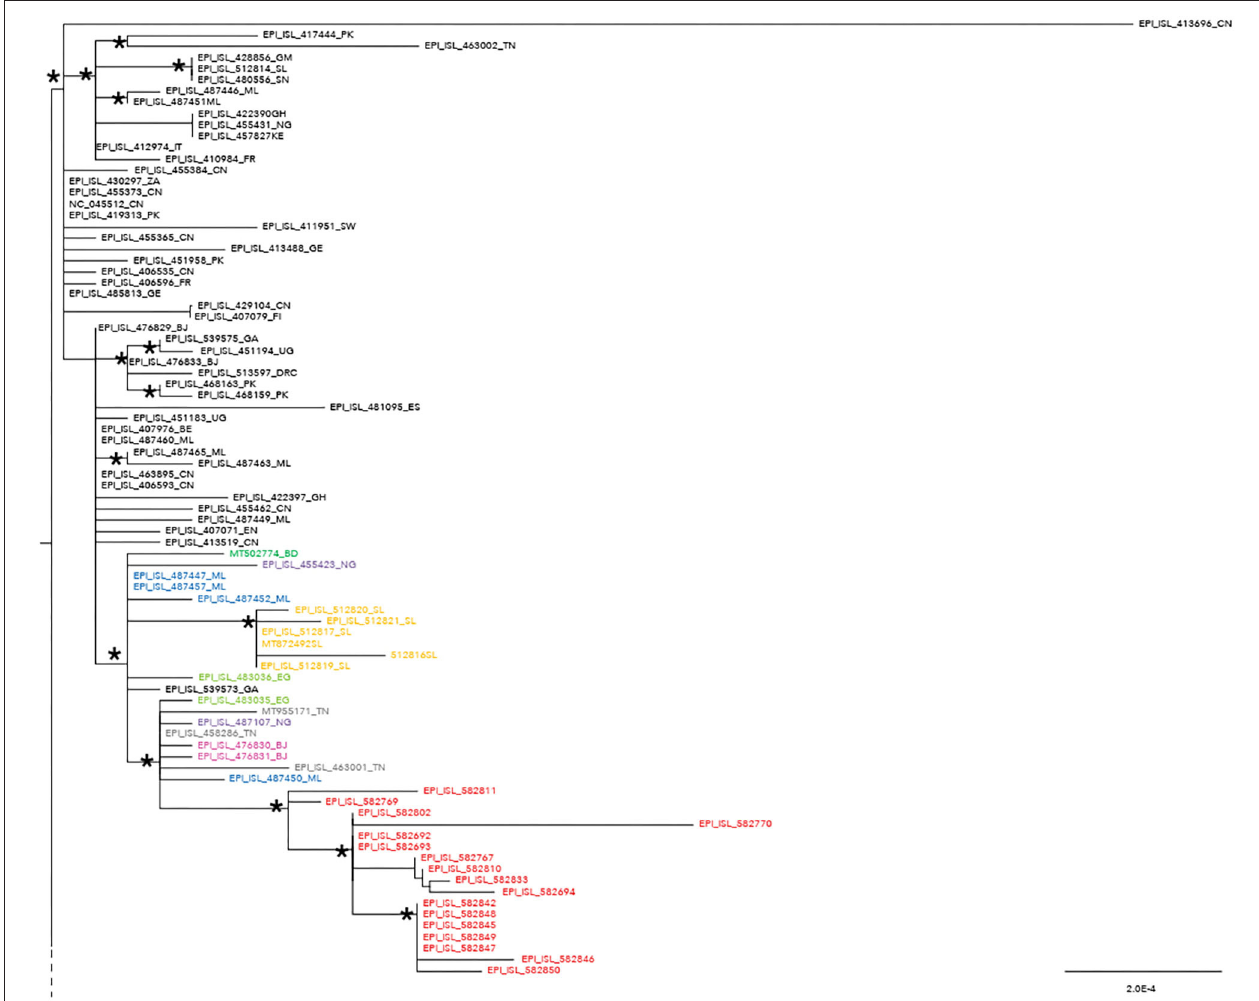
FIGURE 1 | Phylogenetic analysis highlighting the selected clade extrapolated from the whole tree and focusing on the 17 severe acute respiratory syndrome coronavirus 2 (SARS-CoV-2) genomes from migrants (reported in red) belonging to lineage A. These genomes appeared related in a subclade with four genomes from Mali (ML, Mali highlighted in blue: EPI_ISl_487450; EPI_ISL_487447; EPI_ISL_487452; EPI_ISL_487457), one from Bangladesh (BD, Bangladesh reported in dark green: MT502774), two from Benin (Benin, BJ reported in fuchsia: EPI_ISL_476830 and EPI_ISL_476831), two from Nigeria (NG, Nigeria reported in light violet: EPI_ISL_487107; EPI_ISL_455423), six from Sierra Leone (SL, Sierra Leone reported in ocra yellow: EPI_ISL_512816, EPI_ISL_512817, EPI_ISL_512819, EPI_ISL_512820, EPI_ISL_512821, MT872492), three from Tunisia (TN, Tunisia reported in gray: MT955171, EPI_ISL_458286, EPI_ISL_463001), two from Egypt (EG, Egypt highlighted in light green: EPI_ISL_483035 and 483036), and one from Gabon (GA, Gabon reported in black: EPI_ISL_539573). SARS-CoV-2 genomes from other countries can be found externally located to this subclade. An ISO alpha-2 code (www.iso.org) was used at the end of the taxon names to refer to each country. An asterisk along the branches represents an aLRT–aBayes support ≥ 0.99 (Bayesian-like transformation of aLRT available from Phyml software) for the clade subtending that